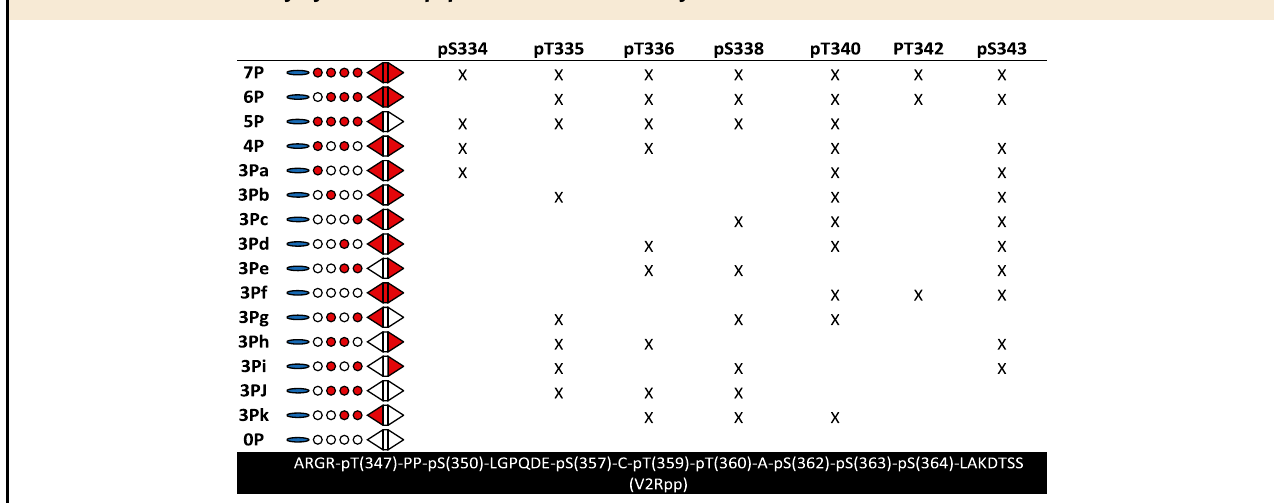
Table 1 List of all chemically synthesized peptides used in this study